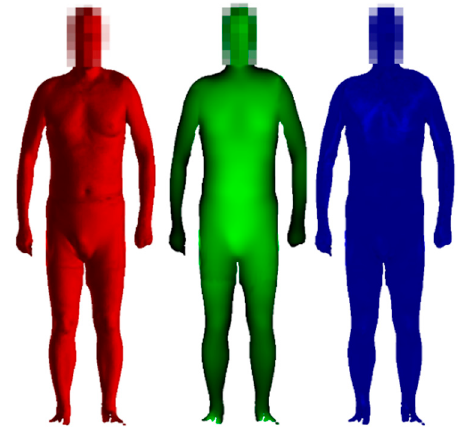
Figure 12. A visualization of calculated layers values for the mid-surface projection: light intensity (red), depth (green) and curvature (blue).